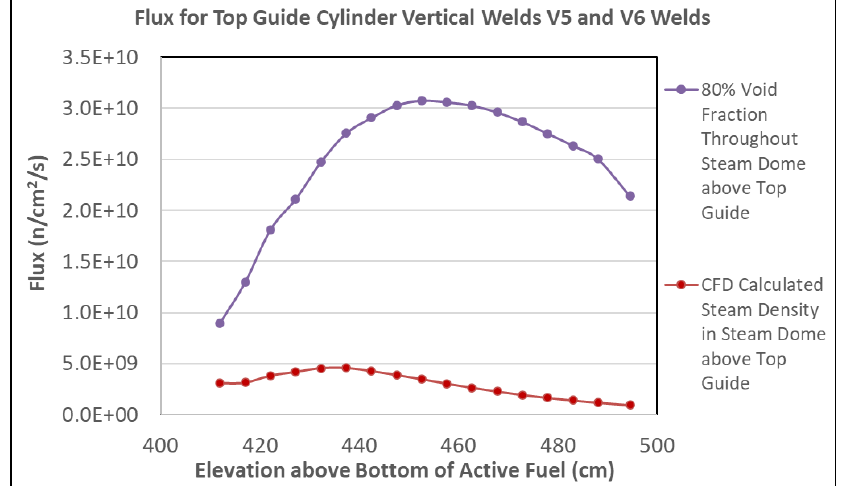
Fig. 3. Comparison of top guide vertical weld fast (E>1 MeV) fluxes determined using the CFD calculated water density compared to the fast flux determined assuming 80 % void fraction above the grid